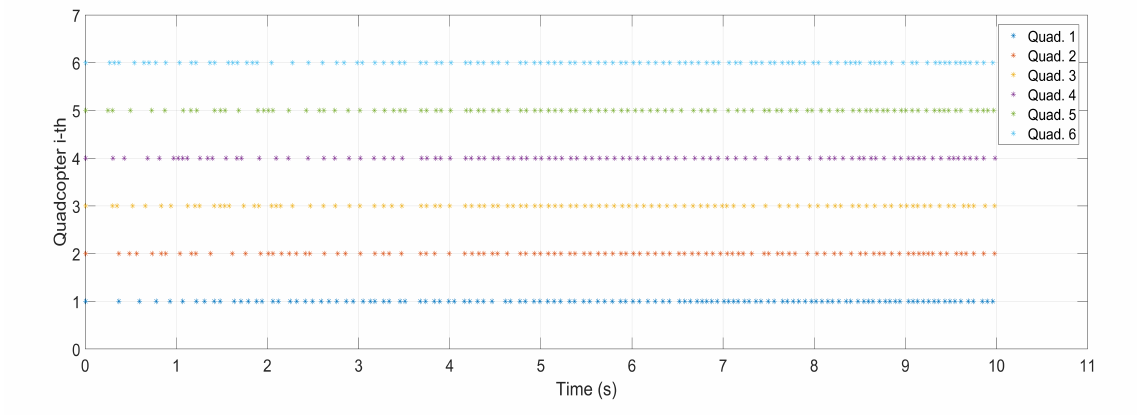
Figure 6. Triggering times of the proposed method applied to the six quadcopters. Table 3. Comparison of the number of triggering times of the proposed dynamic and static event-triggered algorithms in 10 s. Quad.